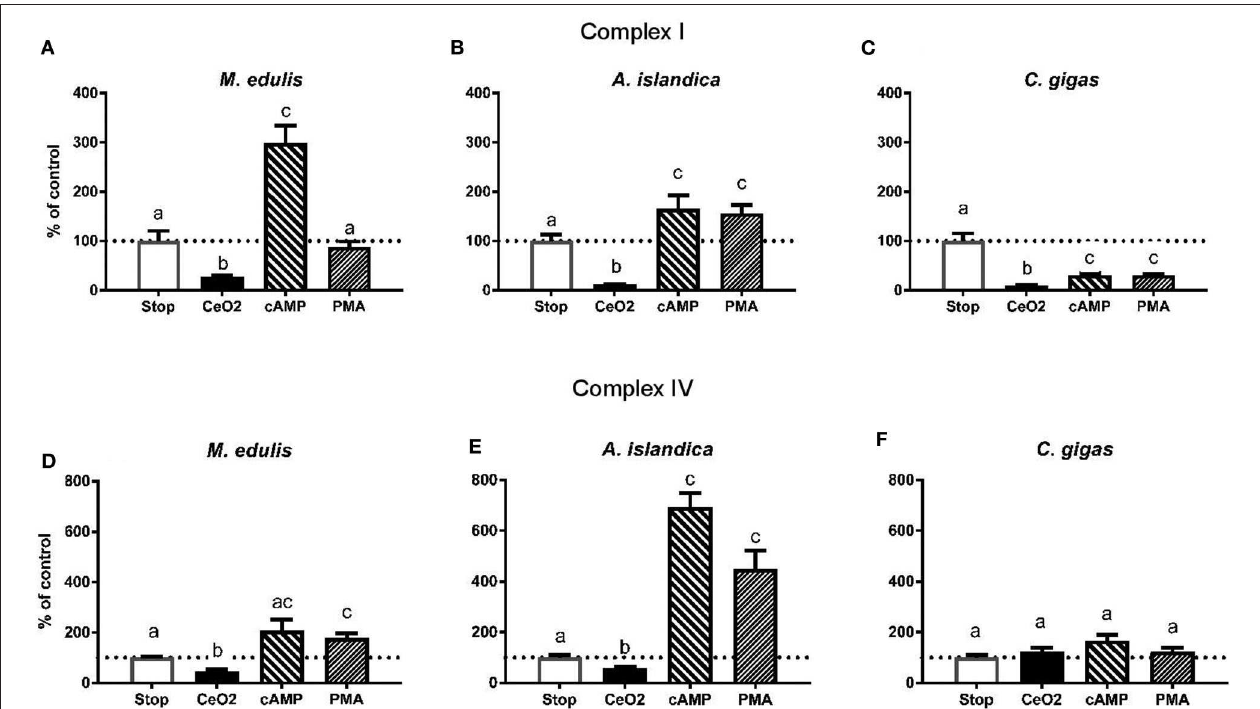
FIGURE 5 | Effects of the experimental manipulation of the phosphorylation state on the activities of the mitochondrial Complexes I and IV in the digestive gland of three species of marine bivalves. (A,D) The mussels M. edulis , (B,E) the quahogs A. islandica , (C,F) the oysters C. gigas . (A–C) The activity of mitochondrial Complex I, (D–F) the activity of mitochondrial Complex IV. Enzymes were isolated from the control (normoxic) animals and treated with CeO 2 (to dephosphorylate the enzymes), cAMP or phorbol myristate acetate to stimulate PKA and PKC activity, respectively. Stop solution contained inhibitors of phosphatases and kinases to preserve the native phosphorylation state. Activities are expressed as % of the respective activity in the native phosphorylation state. Columns that do not share a letter represent significantly different values ( p < 0.05). The vertical bars represent S.E.M. N =